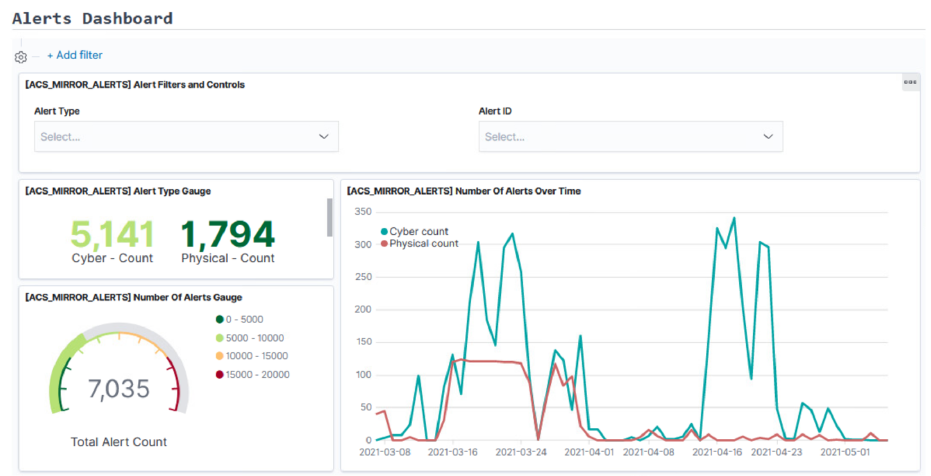
Figure 9. SMS-I Intelligent Dashboard: Alert quantity monitoring visualizations.